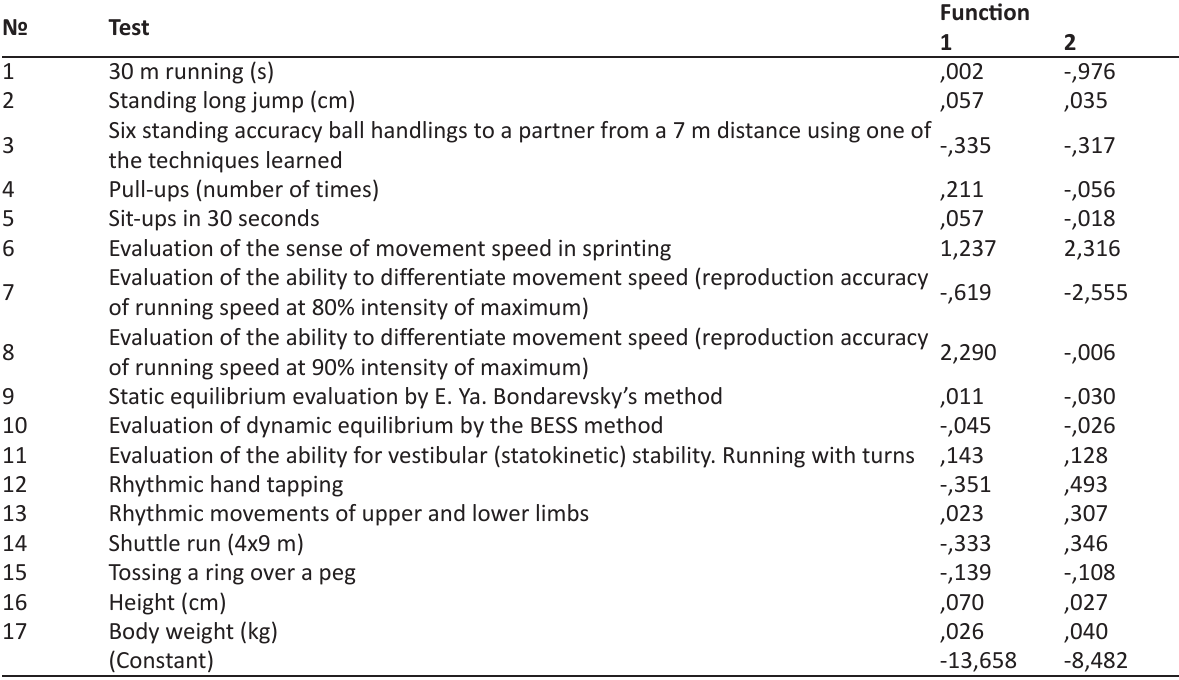
93,3% of original grouped cases correctly classified. Table 6. Canonical Discriminant Function Coefficients. Boys aged 11-13 years old №